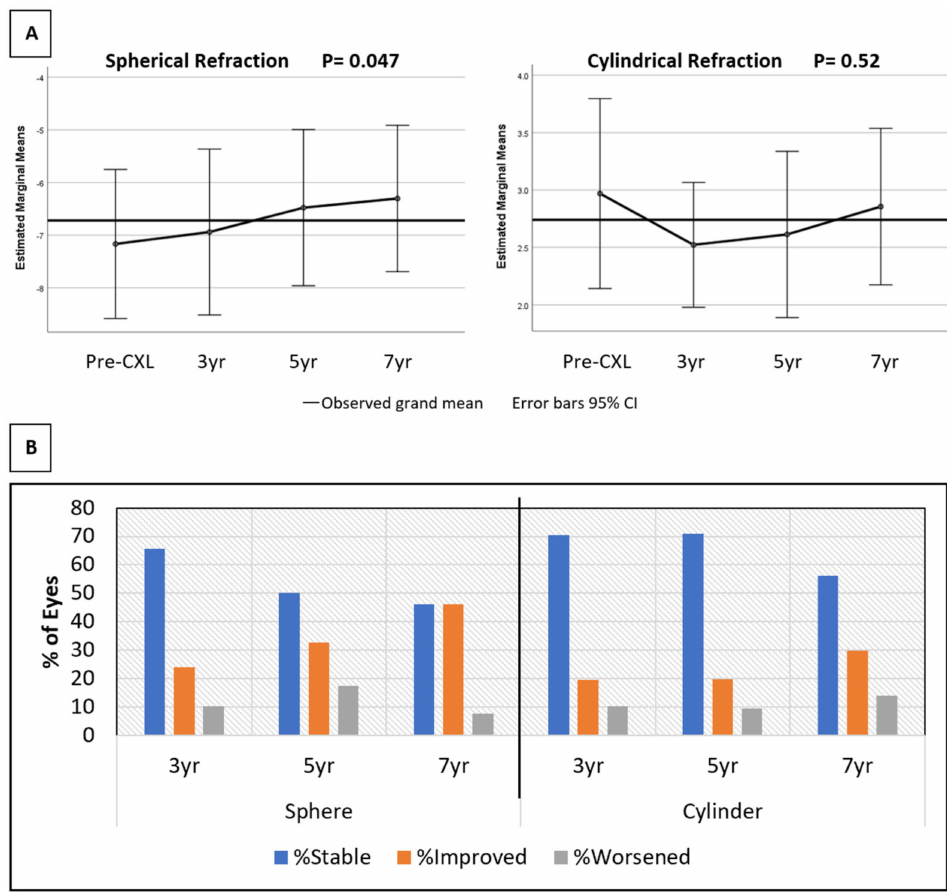
Figure 1. ( A , B ) Change in spherical and cylindrical power from the pre-crosslinking (CXL) value. ( B ): Percentage of eyes with stable (within 1 D), improved (< − 1 D), and worsened (>1 D) refractive values over